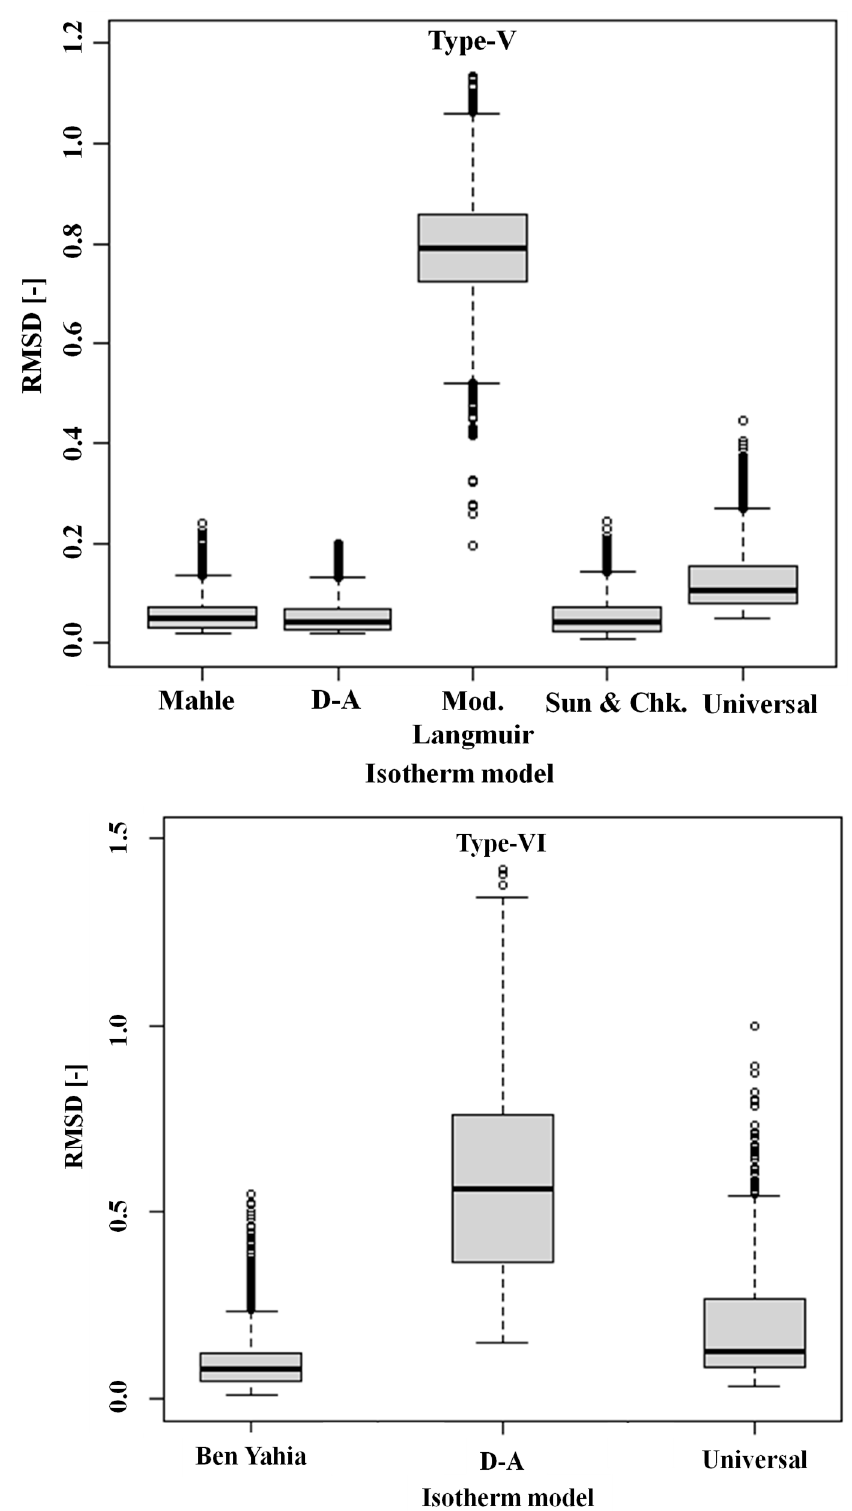
Figure 3. Box-and-whisker plots of the RMSD error (N = 10,000 simulated samples) were presented for all eight IUPAC classified isotherms.